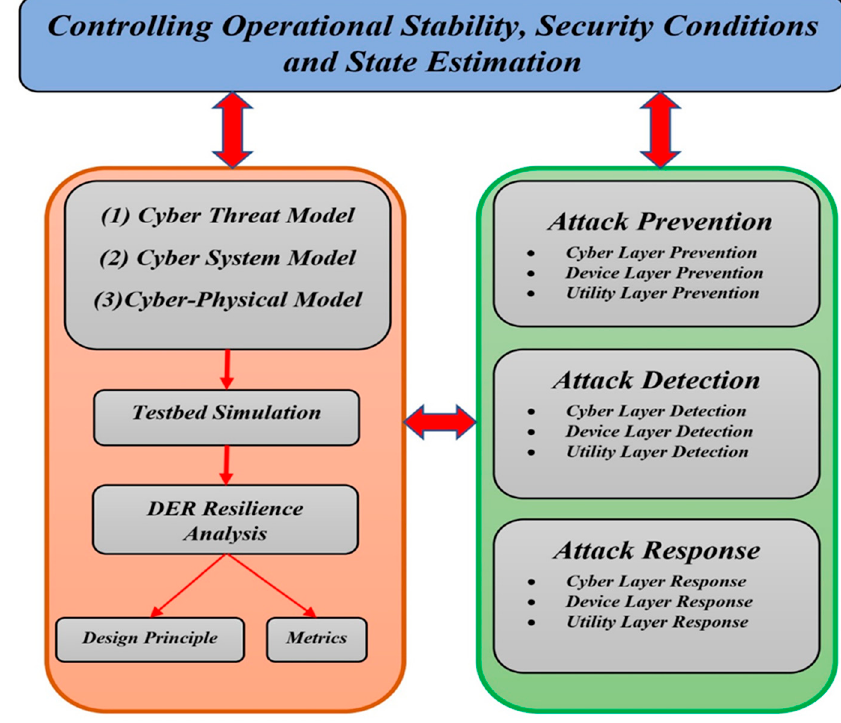
Figure 8. General paradigm of cybersecurity in smart grids.